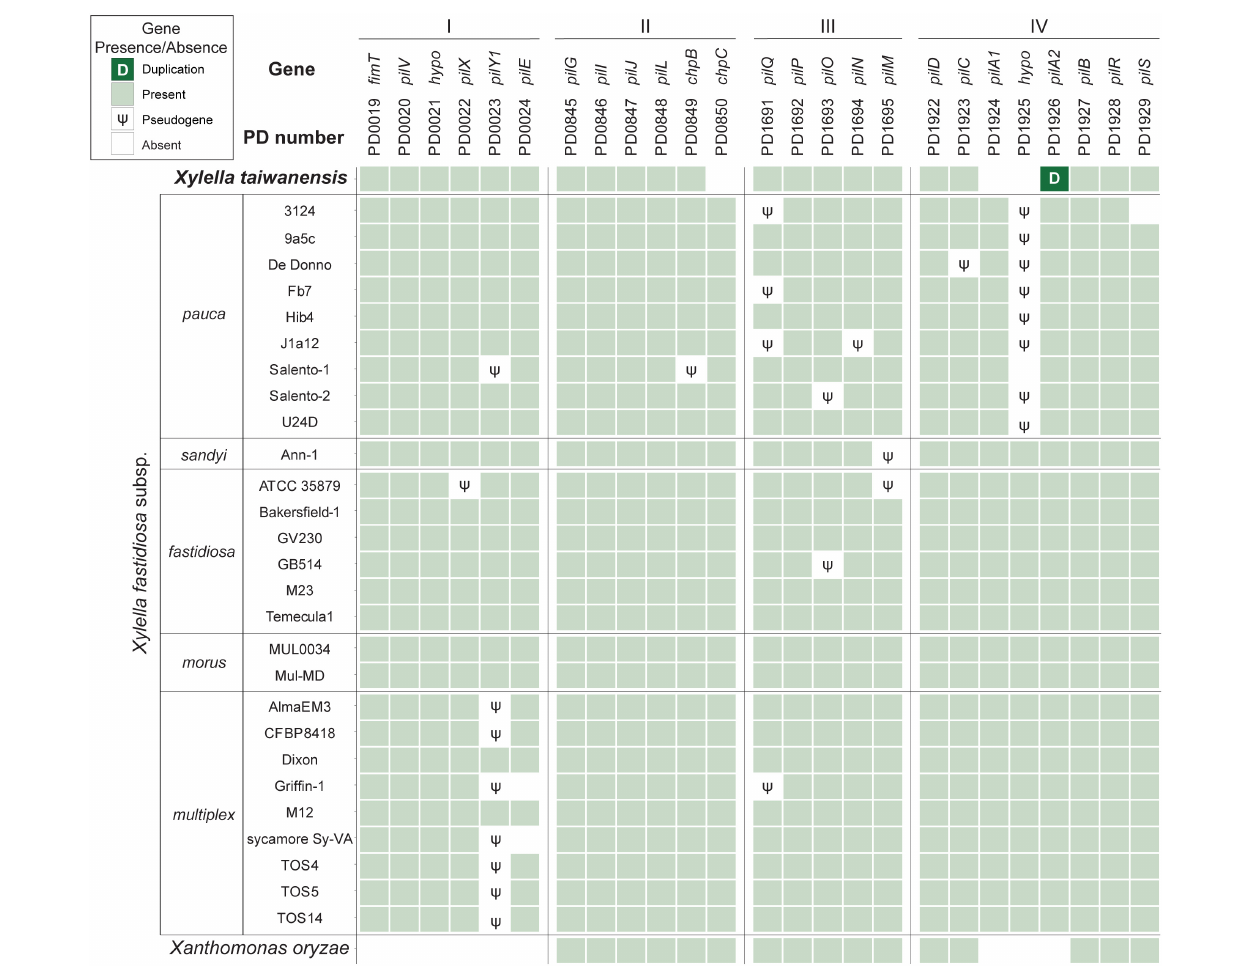
FIGURE 4 | Distribution of the type IV pili genes found among representative Xylella genomes. Xanthomonas oryzae was included as the outgroup. The genes were identified by the PD numbers based on the annotation of Temecula1 genome; those with adjacent PD numbers are located in neighboring regions on the chromosome. A total of four gene clusters (labeled as I–IV) located in syntenic regions were found to be conserved. Gene names were provided when available; “ hypo ” indicates those annotated as encoding hypothetical proteins. Patterns of gene presence and absence were illustrated in the format of a heatmap. For gene absence, those with identifiable pseudogenes were labeled accordingly. One case of tandem gene duplication was observed for the PD1926 ( pilA2 ) homolog in the Xylella taiwanensis